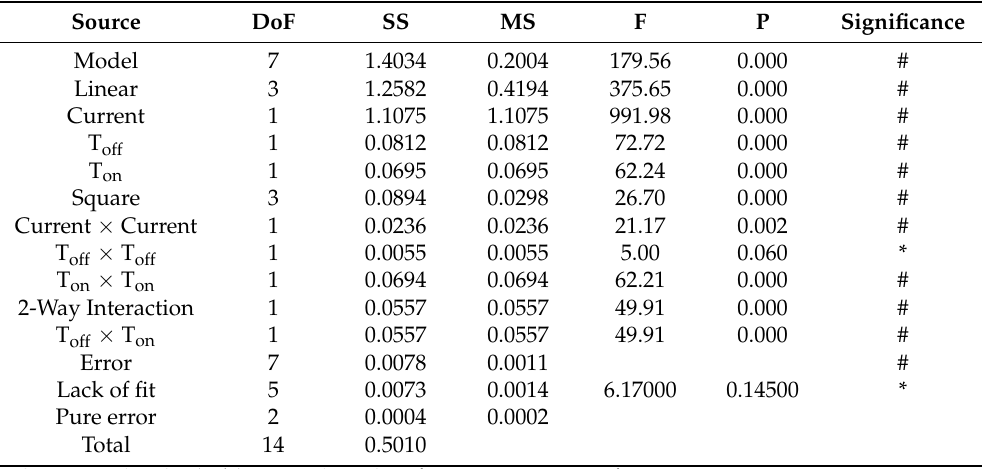
Table 4. ANOVA for MRR.